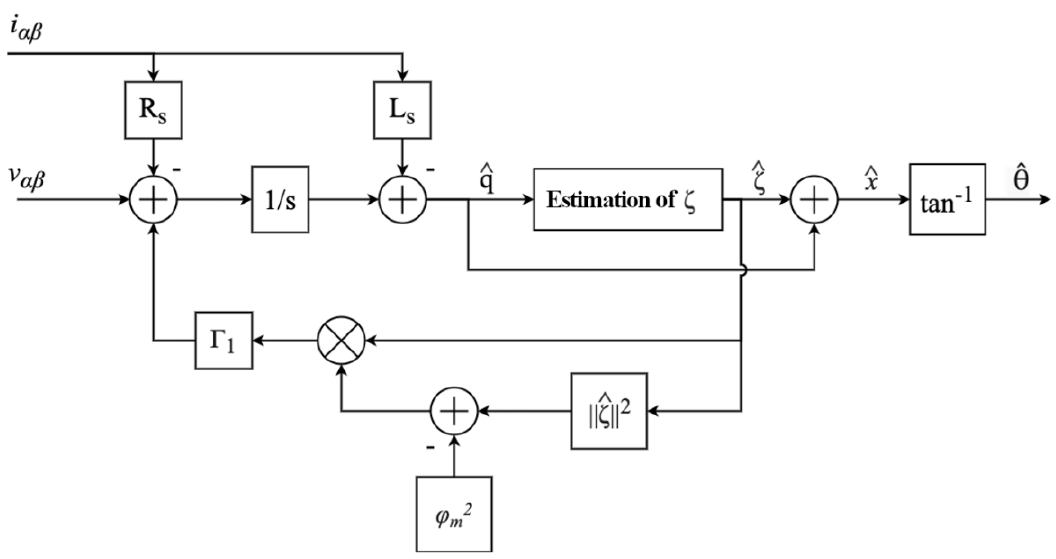
Figure 10. Scheme of the adaptive RFO sensorless algorithm.